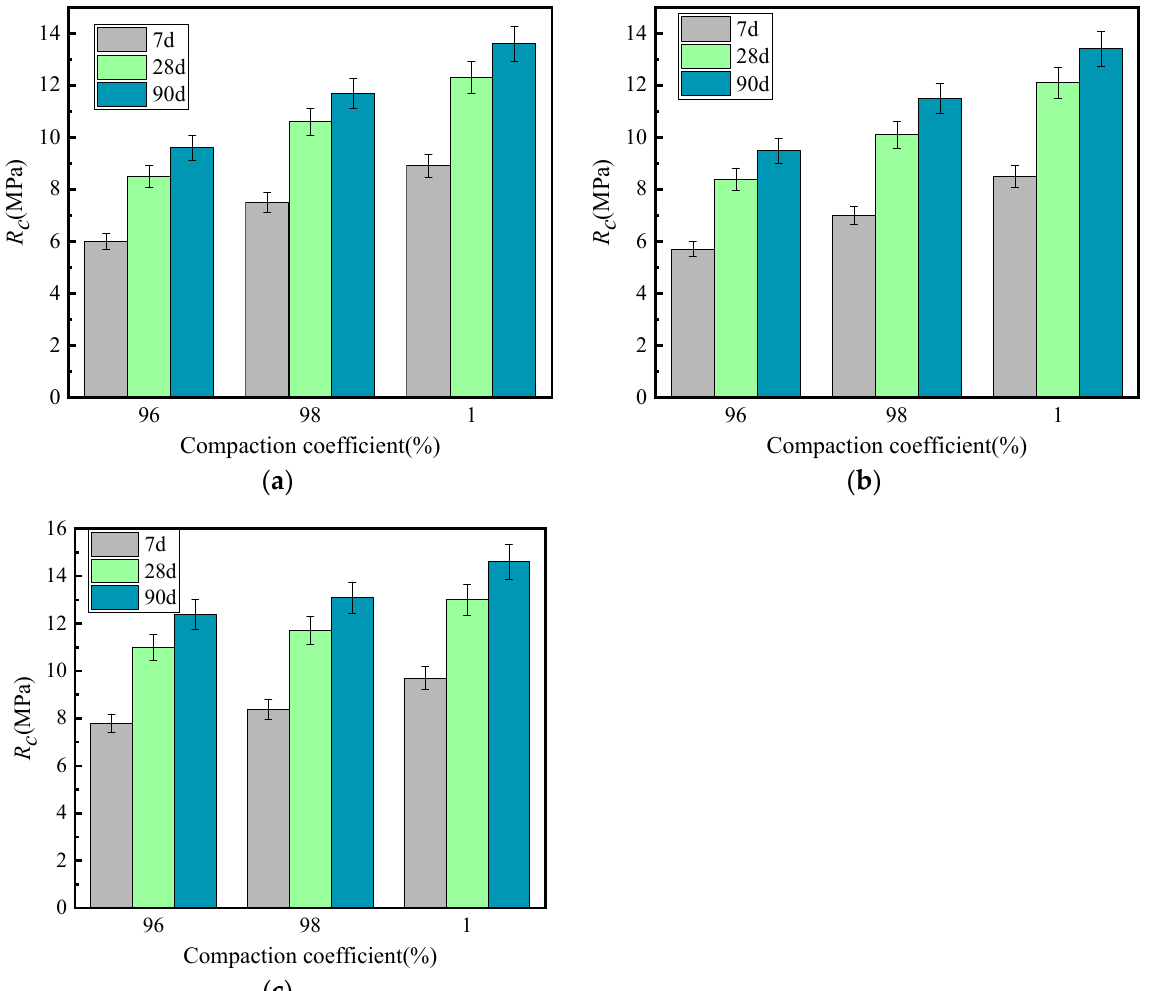
Figure 11. Growth law of unconfined compressive strength under different compaction coefficients. ( a ) GF1, ( b ) GF2, ( c ) VGM-30.